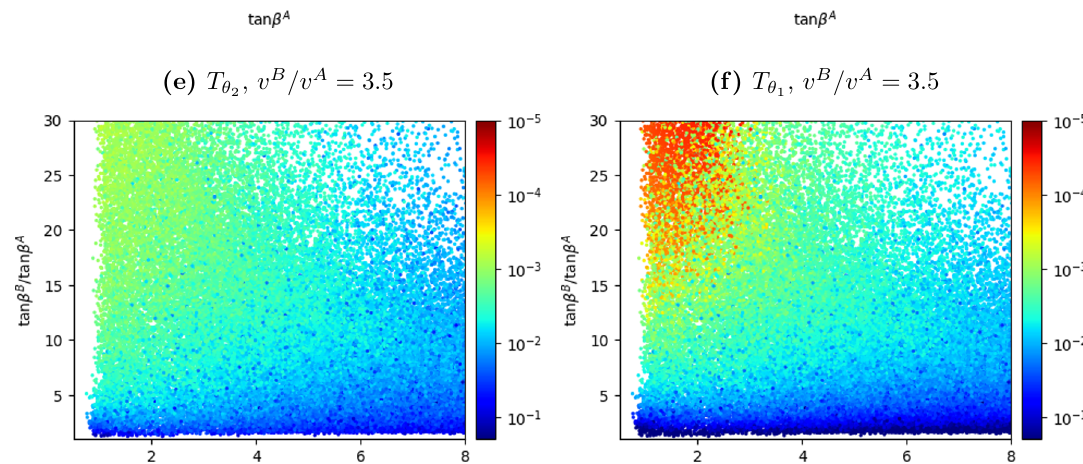
(left) and T (cid:18) (right). 2 1